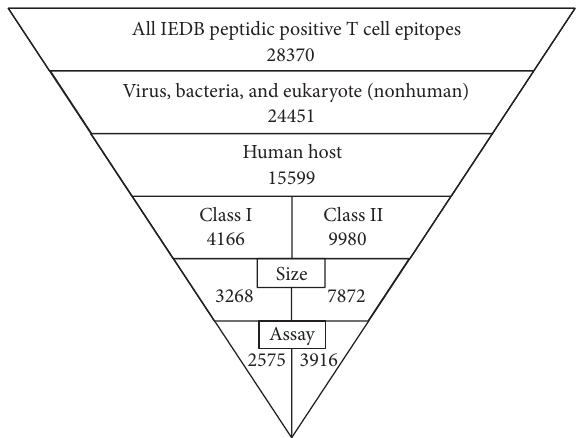
Figure1:Diagramofthefilteringstepstowardsthegenerationofthe validated sets of epitopes, including the number of epitopes found in each